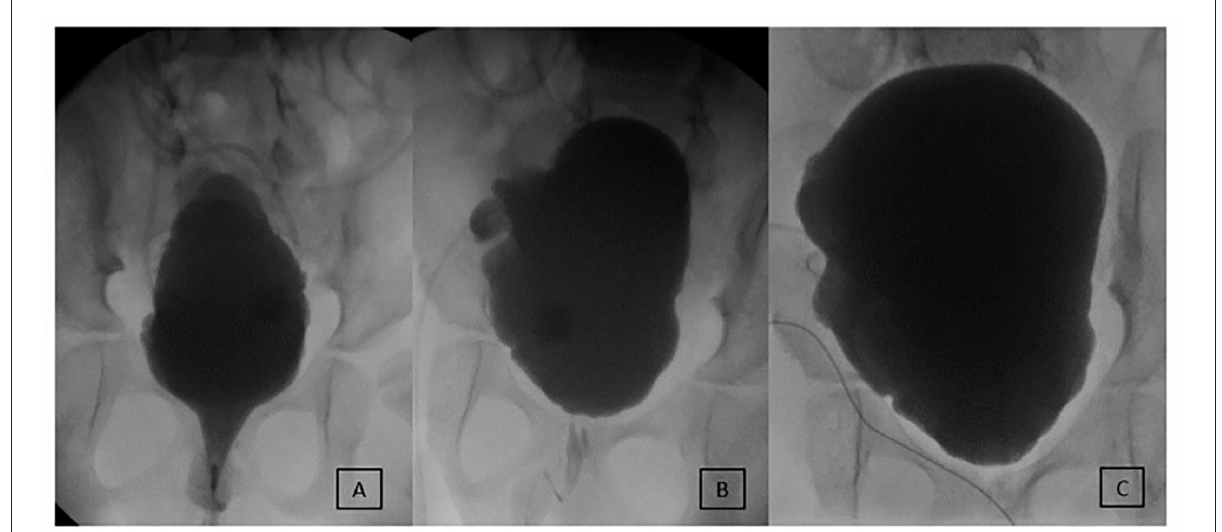
FIGURE4 Evolution of early incontinence in an 8-year-old male after MMBNR with sling and augmentation. (A) Preoperative testing shows an open bladder neck and leak point pressure of 36cm H 2 O at 220ml. No NDO observed. (B) 8 months postoperatively, intermittent incontinence occurs per urethra clinically and on first urodynamics. Leakage occurred at 225ml with NDO of 25cm H 2 O overlying mildly impaired compliance. Botox injections to the bladder wall resolved incontinence. (C) Now 4 years postop, bladder neck appears competent and elevated. He is continent daytime and has scant moisture per urethra overnight with no additional procedures. He does remain on anticholinergics to manage NDO.